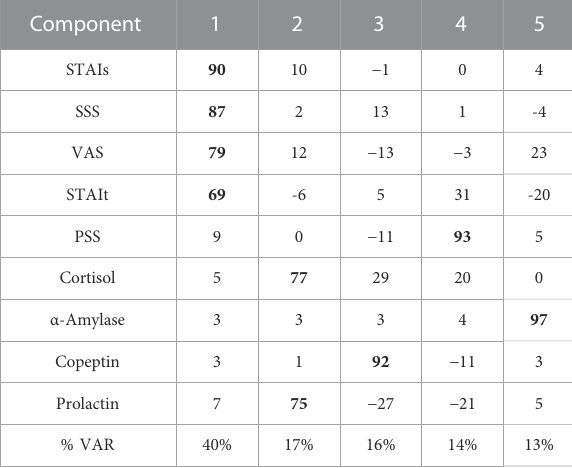
TABLE 7 Scoring coef fi cients for computing component scores. Component